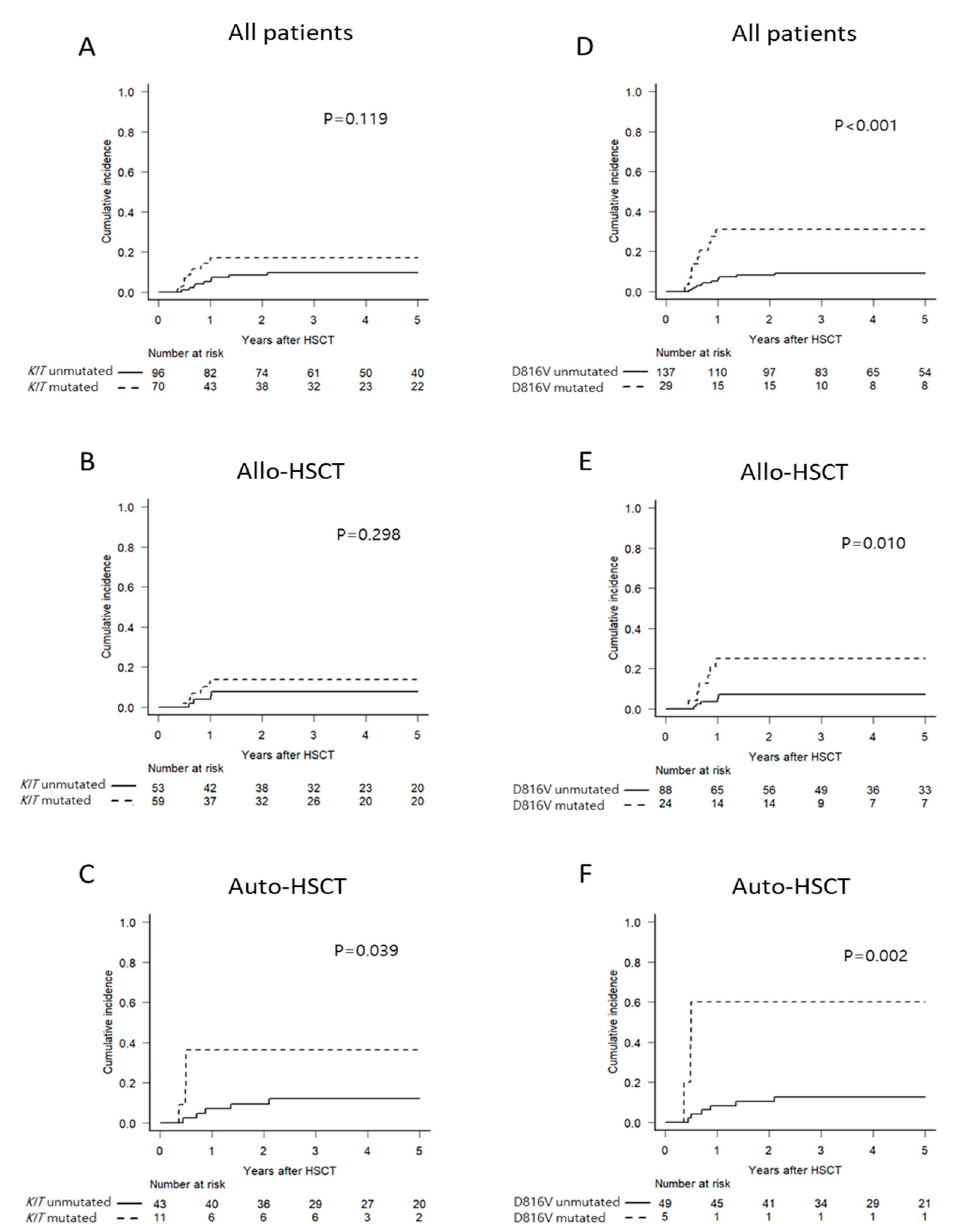
Figure 1. Cumulative incidence of relapse according to KIT mutations ( A – C ) or D816V KIT mutation ( D – F ) in all patients ( A , D ) or patients in Allo-HSCT ( B , E ) and Auto-HSCT ( C , F ) groups. 2.3. Optimal Time Points and Thresholds for RUNX1–RUNX1T1 MRD Monitoring